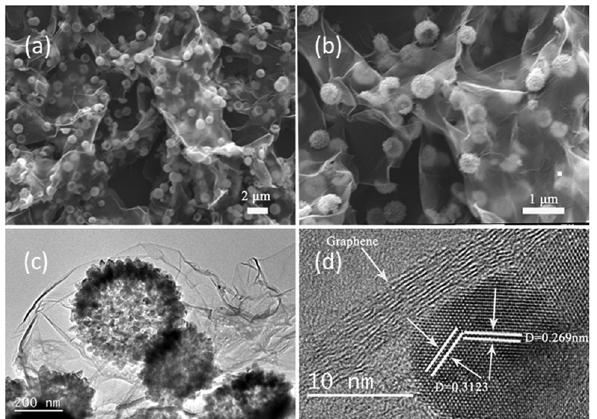
Figure 1: ( a ) Low and ( b ) high magni fi cation SEM images of Zn 0.76 Co 0.24 S@N/S - rGO. ( c ) TEM images of Zn 0.76 Co 0.24 S@N/S - rGO. (